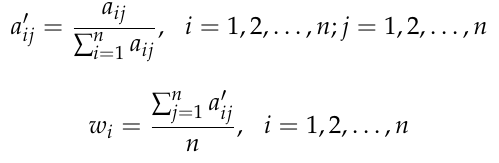
Table 1. Gradation scale for pairwise comparisons [28].